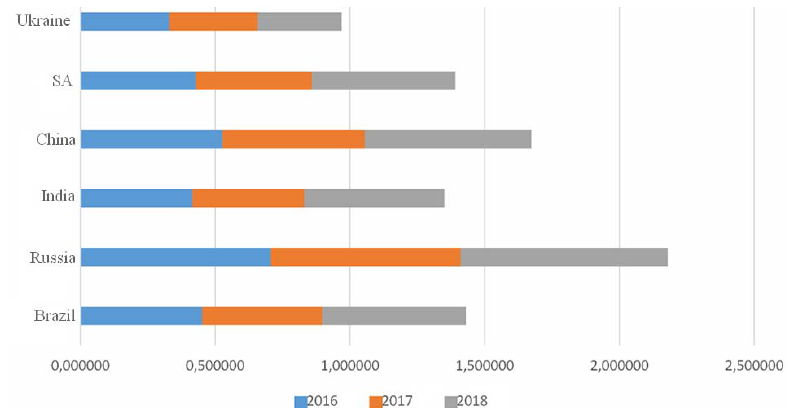
Fig. 1. Forecasting meanings of integral index reflecting integration development level of Ukraine and BRICS member countries in perspective period (2016-2018)